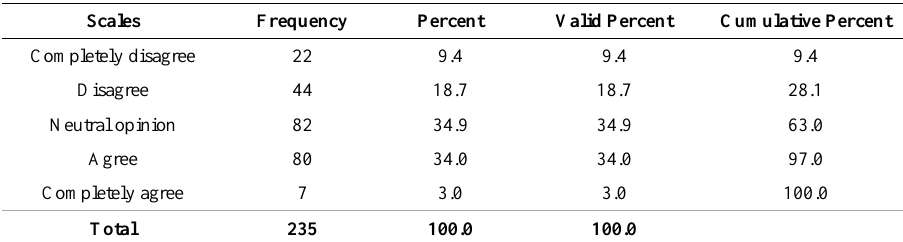
Table 4. Enterprises enhancing the capacity to meet the market